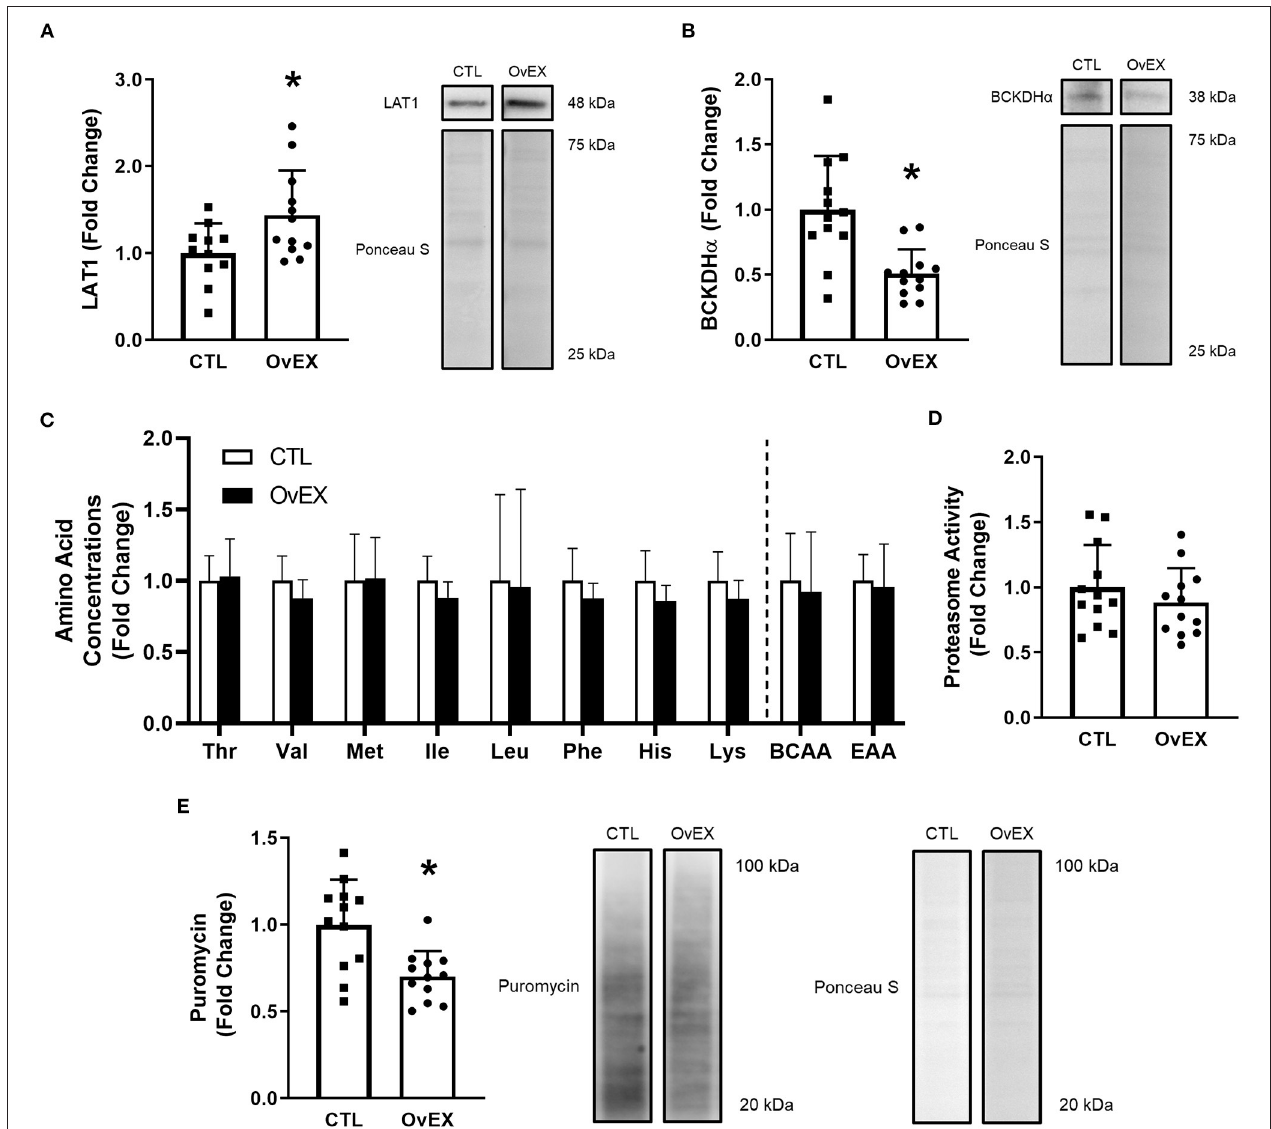
FIGURE 5 | LAT1 protein overexpression in C2C12 myoblasts decreases protein synthesis. Overexpression of LAT1 protein (OvEX) increases LAT1 protein (A) but decreases BCKDH α protein (B) compared to control (CTL). Amino acid concentrations from whole cell lysates (C) as well as proteasome activity (D) were unaltered by LAT1 protein overexpression. Puromycin incorporation, a surrogate for protein synthesis, decreased following LAT1 overexpression (E) . Representative images for each measured protein accompany each panel. In panel C open columns represent CTL and closed columns represent OvEX. * p < 0.050 compared to control. Sample sizes for each treatment group was CTL = 11–12 and OvEX = 12 with the exception of (C) as each group’s sample size was